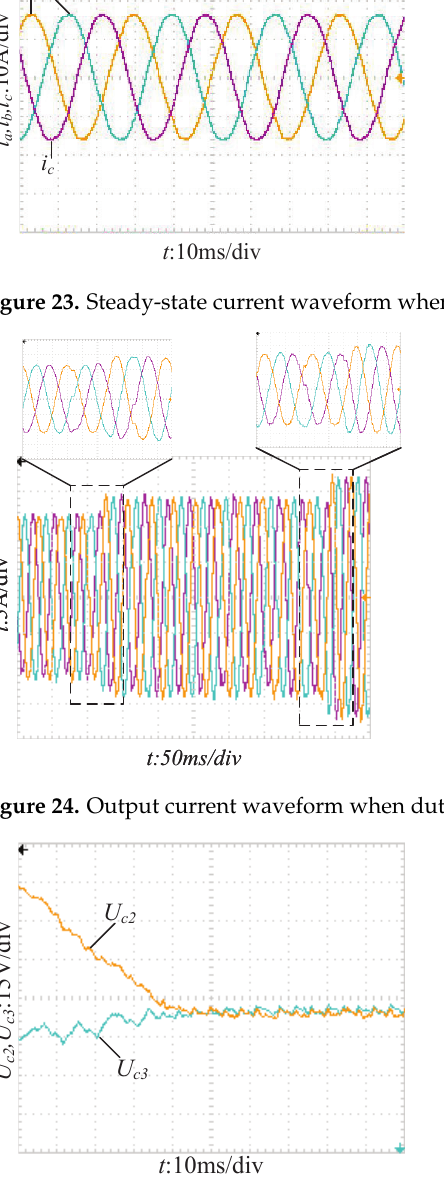
Figure 25. Voltage waveform of upper and lower capacitors under neutral point voltage